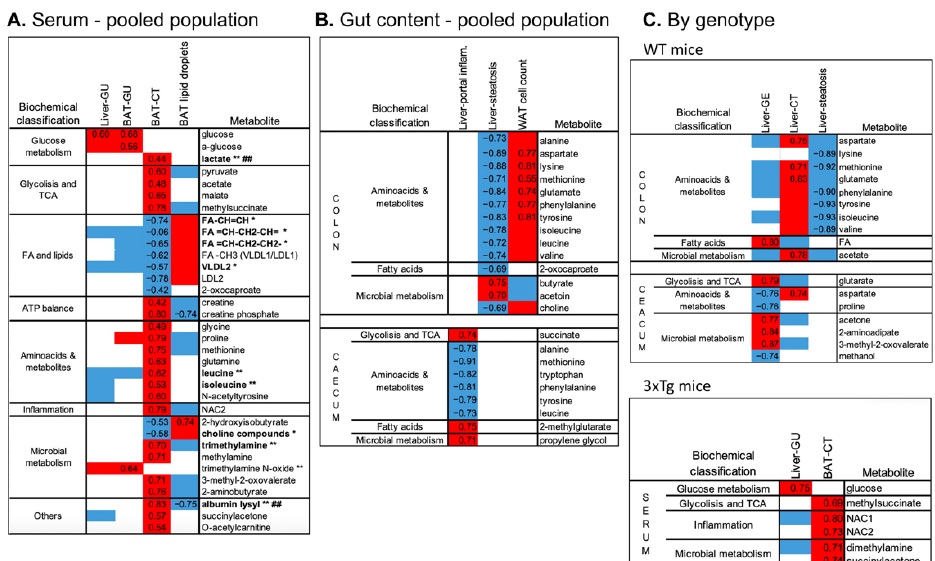
Figure 4. Top significant correlations between imaging and histological parameters and serum ( A ) or colon and caecum fecal metabolome ( B ) assessed in the pooled population ( A , B ) or the two genotypes separately ( C ). In the heatmaps, red and blue colors indicate positive and negative correlations, respectively. Spearman’s rho of correlations surviving FDR correction are reported, whereas for univariate correlations not surviving the FDR correction, Spearman’s rho are not reported, but the direction of the association is indicated by the red/blue color. Bold type and symbols are used to highlight metabolites previously shown to be higher (**) or lower (*) in the 3xTg compared to WT mice or shown to be higher (##) in HFD compared to ND fed mice.